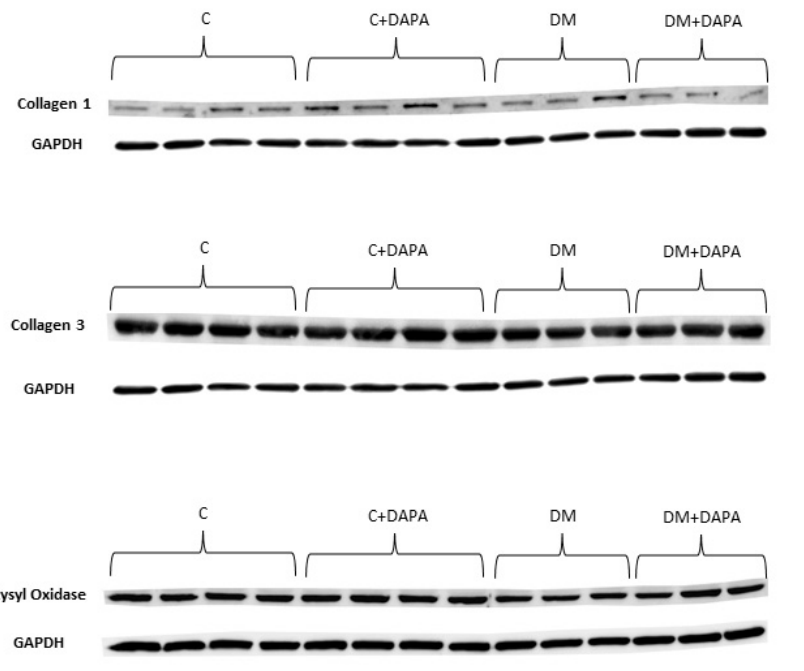
Figure 3. Representative Western blots. C: control; C + DAPA: control treated with dapagliflozin; DM: diabetes mellitus; DM + DAPA: DM treated with dapagliflozin. DM had higher myocardial lipid hydroperoxide concentration and lower anti-oxidant enzyme activities than C. DM + DAPA had lower lipid hydroperoxide concentration and higher superoxide dismutase and glutathione peroxidase activity than DM (Figure 4). Ad- vanced glycation end products did not differ between groups [C 0.88 (0.67–1.73); C + DAPA 1.29 (0.81–1.66); DM 1.02 (0.71–1.23); DM + DAPA 1.29 (0.80–1.88)%; p > 0.05].